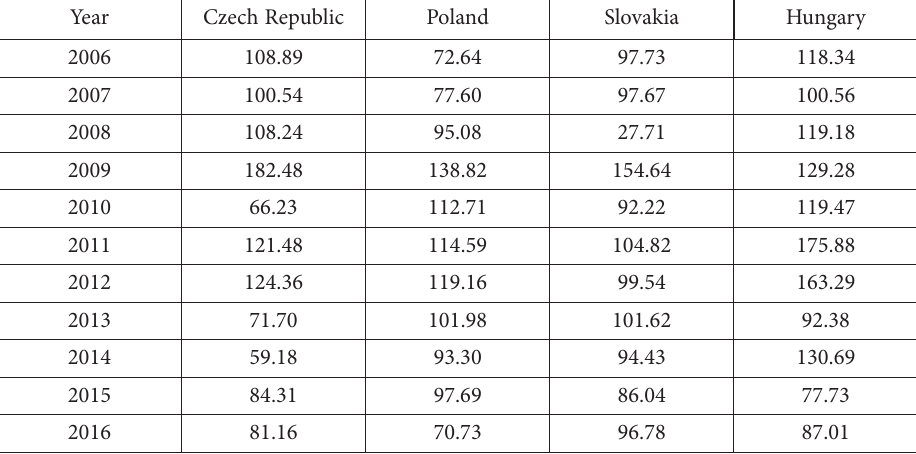
Table 2. The chain indices of the number of bankruptcies in the Visegrad Group countries (source: Own work) Year